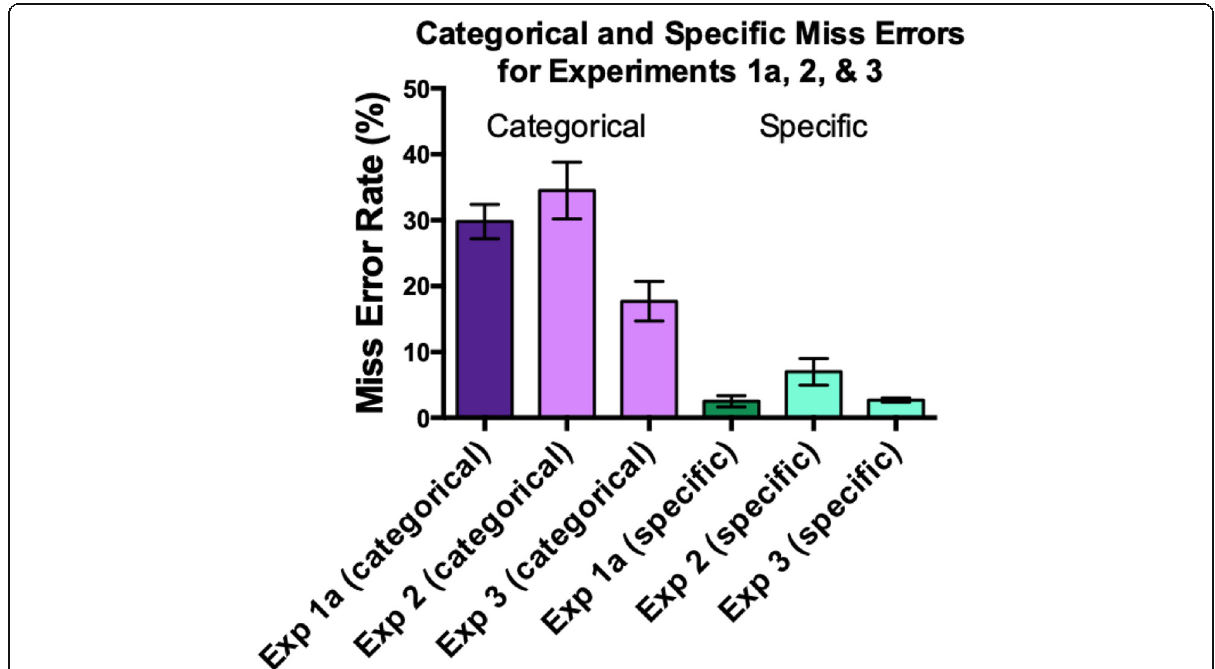
Fig. 8 Miss rates for categorical and specific targets in Experiment 3, compared to Experiments 1a and 2. Error bars are ± 1 SEM